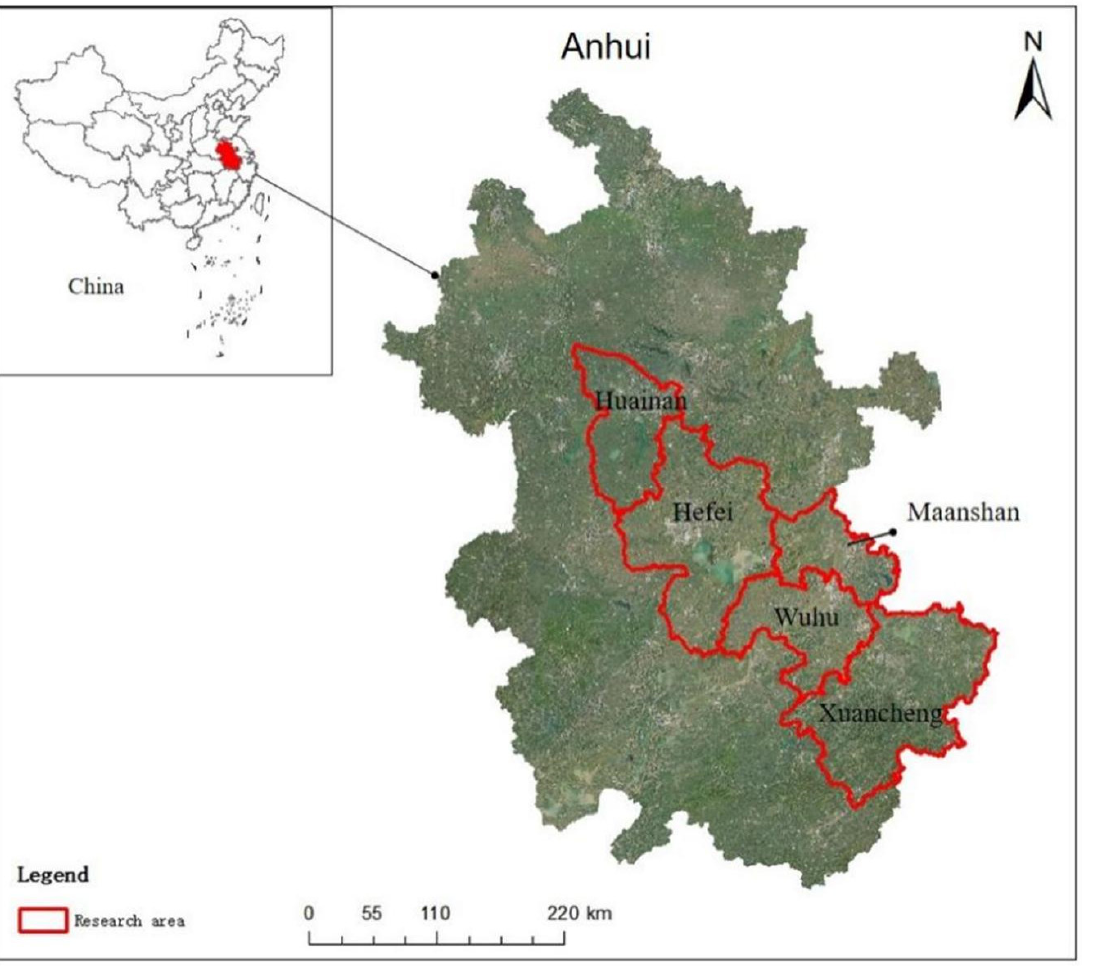
Figure 2. Study area.